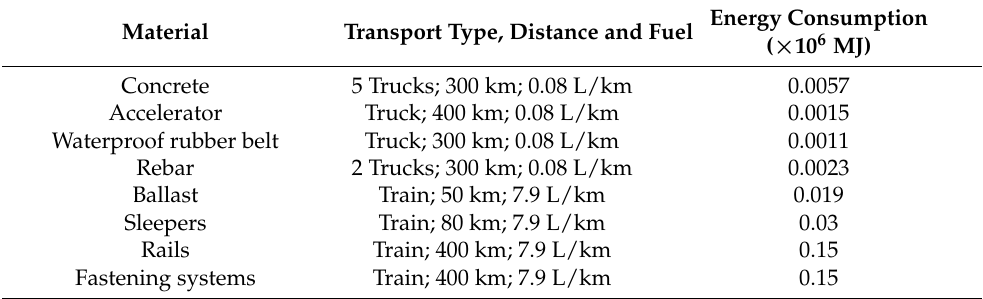
Table 3. Transportation characteristics and energy consumption for a railway tunnel construction [31].